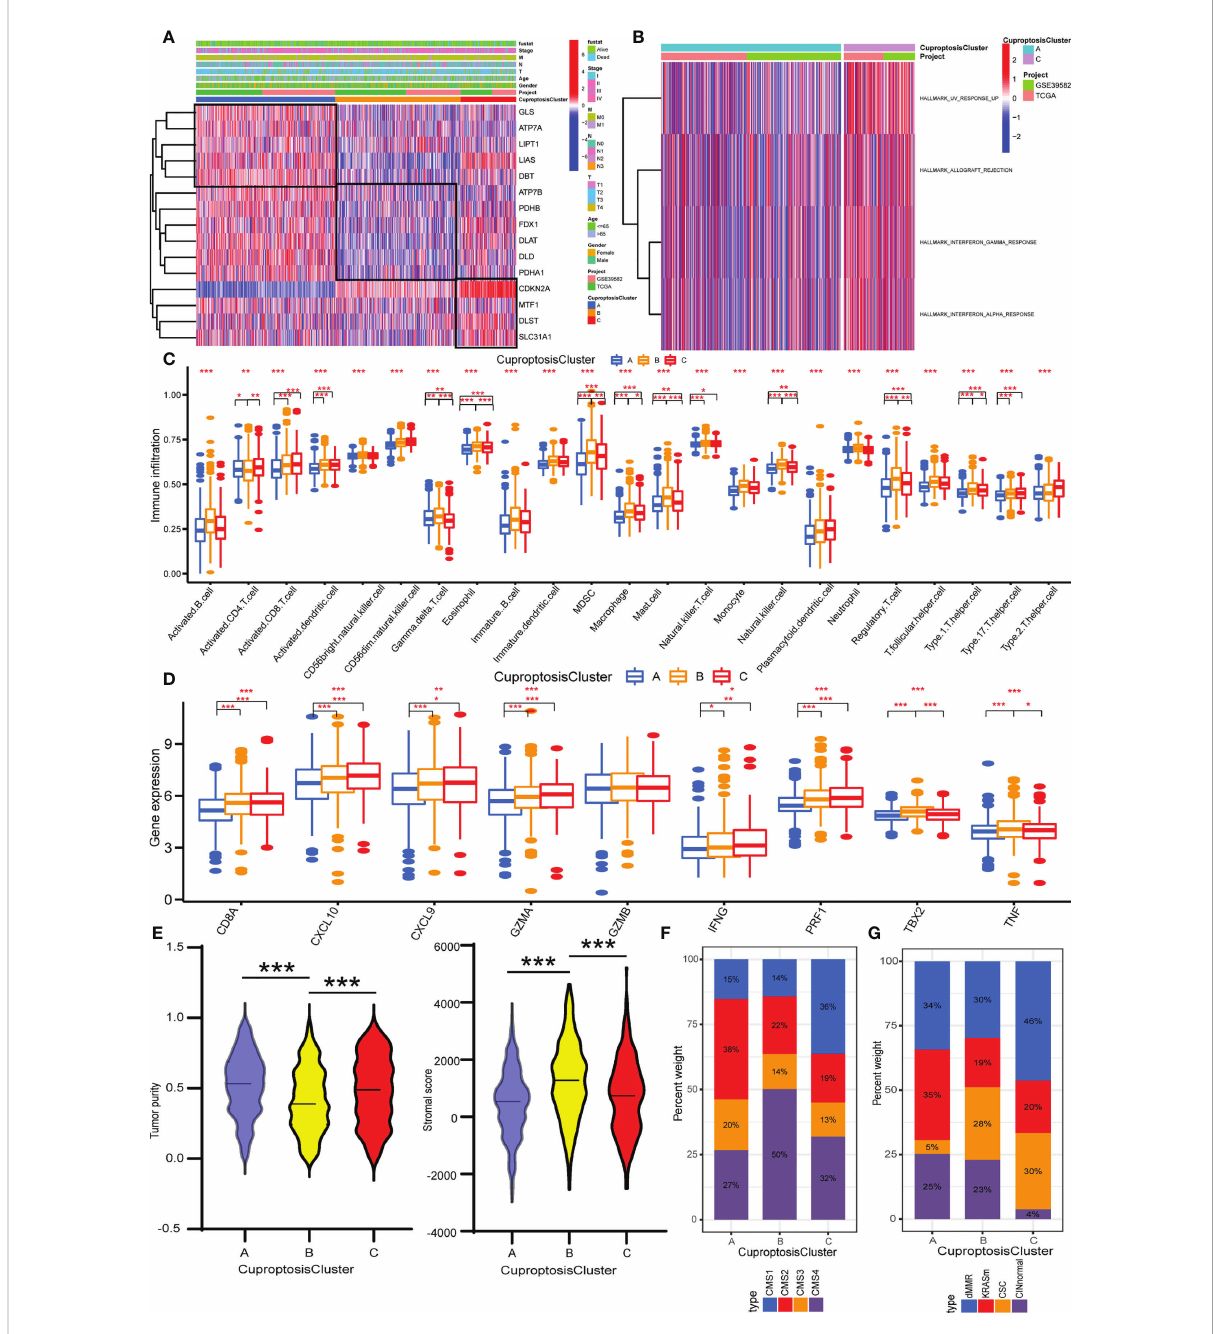
FIGURE 2 Identi fi cation of cuproptosis patterns and their TME characteristics in colorectal cancer. (A) Unsupervised consensus clustering of 16 cuproptosis regulators in the TCGA and GEO data. The CuproptosisCluster, gender, age, T stage, N stage, M stage, TNM stage, and survival status were used as annotations. (B) GSVA enrichment analysis showing the biological processes in CuproptosisClusters A and C. (C) The abundance analysis of each immune cell in the TME of three CuproptosisClusters. (D) The expression levels of immune activity related genes in three CuproptosisClusters. (E) The stromal score and tumor purity in three CuproptosisClusters with ESTIMATE algorithm. (F) The CMS analysis of the three CuproptosisClusters. (G) The molecular subtypes analysis of GSE39582 dataset in three CuproptosisClusters. *P <0.05; **P <0.01; ***P